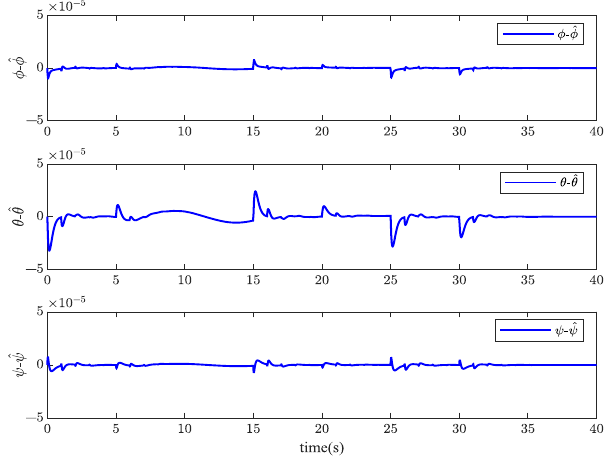
Figure 3. The roll angle φ , pitch angle θ , yaw angle ψ , and their estimation ˆ φ , ˆ θ and ˆ ψ when z = 1 s.